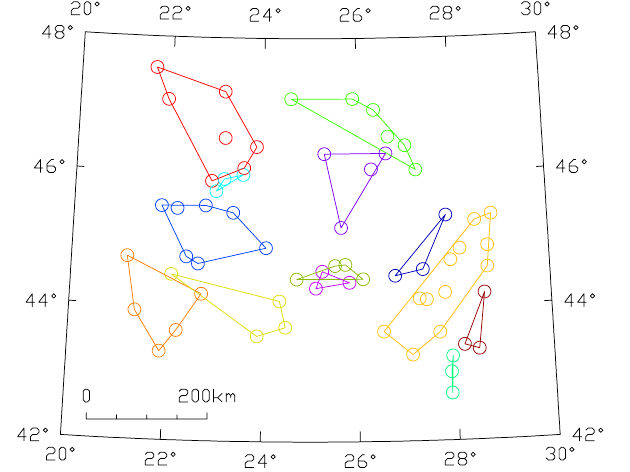
Figure 7. Simulated example: residual plot and initial subsets of places.